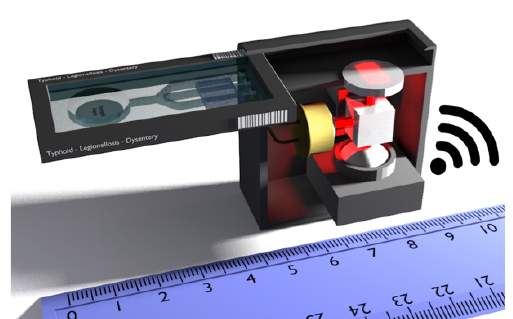
Figure 1. Artist’s impression of a handheld sensor device exploiting the simple excitation of guided mode resonances.